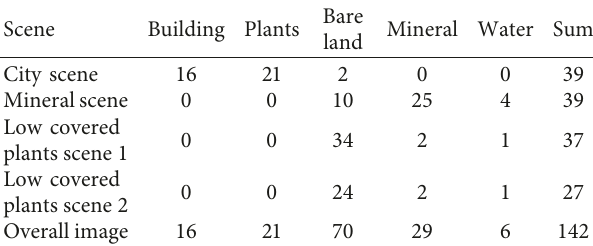
Figure 3: Scene division result of image A.